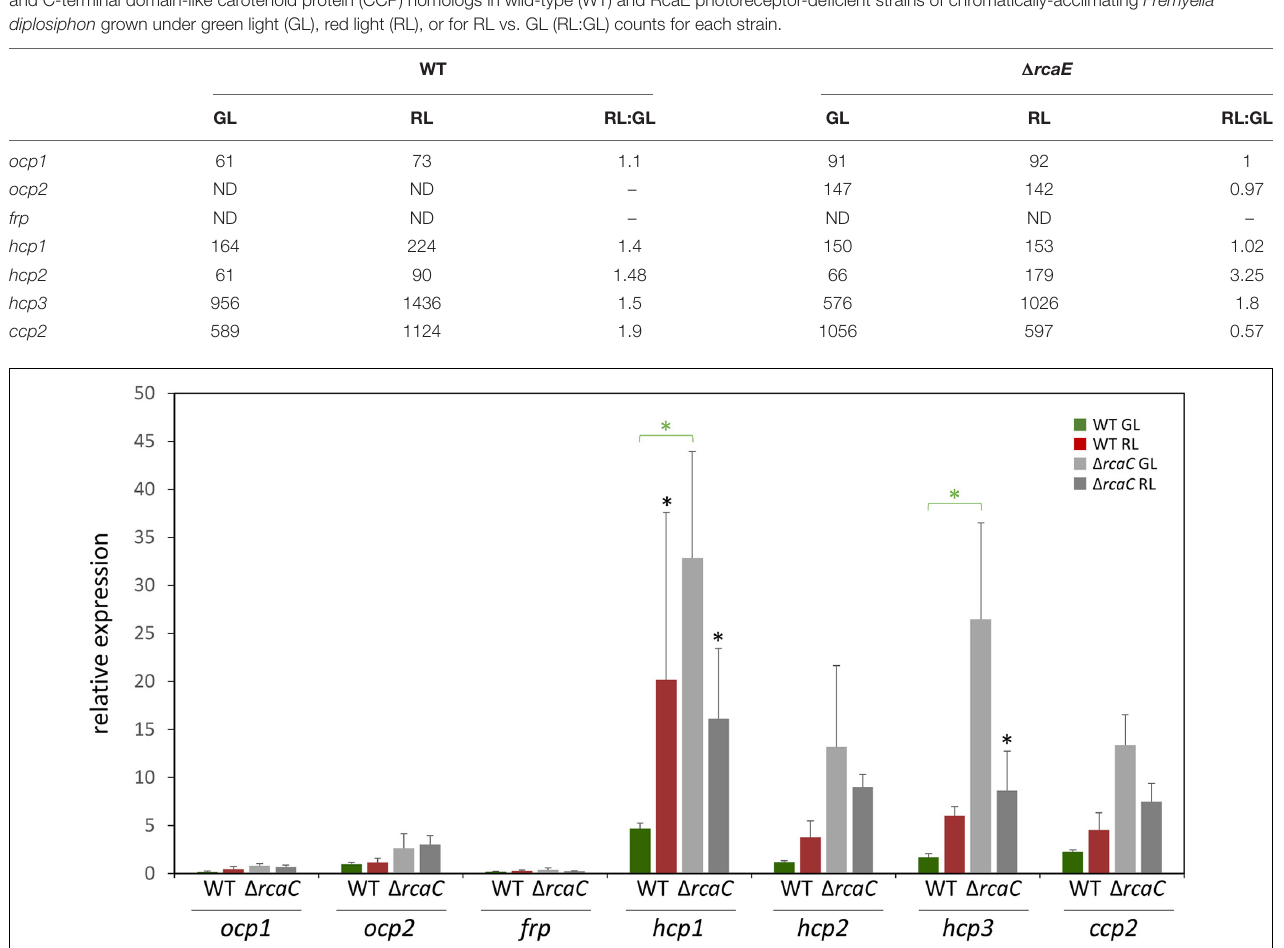
FIGURE 2 | Expression of ocp homologs in the (cid:49) rcaC strain of F . diplosiphon . Wild type and (cid:49) rcaC strains of F . diplosiphon cultures were grown under green and red light at light intensities of 20 µ mol m − 2 s − 1 . Relative expression of ocp1 , ocp2 , frp , hcp1 , hcp2 , hcp3 , and ccp2 were measured using qPCR, comparing samples from the (cid:49) rcaC mutant to samples from SF33. ( ± SD, n = 4). ∗ p < 0.05, with dark gray stars indicating a difference for a strain in GL compared to RL, and green stars indicating a difference between WT and the (cid:49) rcaC mutant grown in GL as determined by a ANOVA with Tukey-Kramer HSD post hoc test.